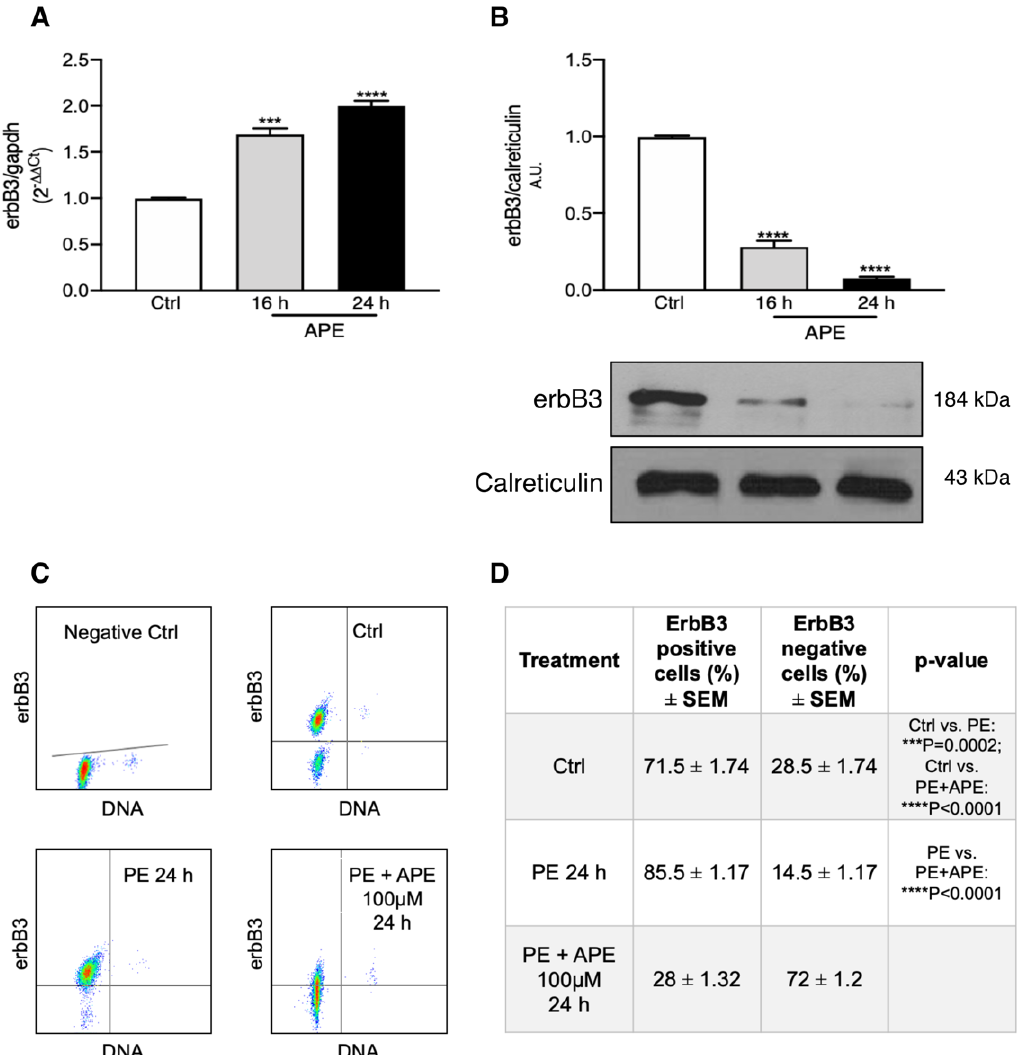
Figure 6. ErbB3 receptor expression in SCs. ( A ) qRT-PCR analysis shows that erbB3 receptor transcript levels are upregulated already after 16 h and 24 h of APE treatment (*** p < 0.001; **** p < 0.0001; n = 3); ( B ) Representative Western blot analysis for erbB3 receptor. The expression of the receptor is significantly downregulated after 16 and 24 h of 100 µM APE treatment. The graph shows the average ± SEM of the OD of the bands normalized against the OD of the calreticulin, used as reference protein (Figure 3B; **** p < 0.0001; n = 3). ( C , D ) FACS analysis for erbB3 receptor shows a significant increase in the percentage of erbB3 positive cells after PE treatment (85.5 ± 1.17; Ctrl vs. PE *** p = 0.0002; n = 3) and a decrease in erbB3 positive cells after APE treatment (28 ± 1.32; PE vs. PE + APE, **** p < 0.0001; n = 3).